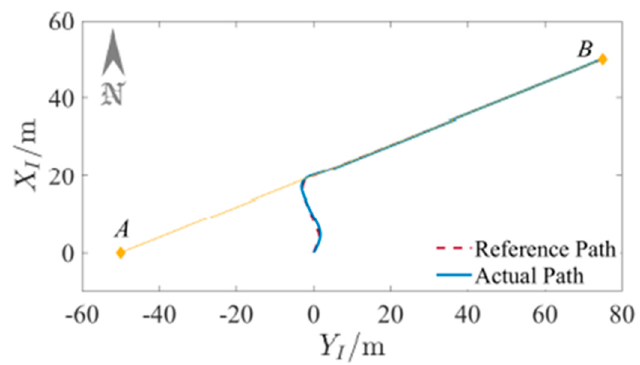
24 of 42 Figure 18. The track diagram of straight-line tracking based on PID guidance law. Choose to apply ATD guidance law under the condition where the error feedback gain is unchanged. The upper limits of ground velocity and horizontal acceleration are, respectively, 4 / lmt v m s = and 2 2 / lmt a m s =